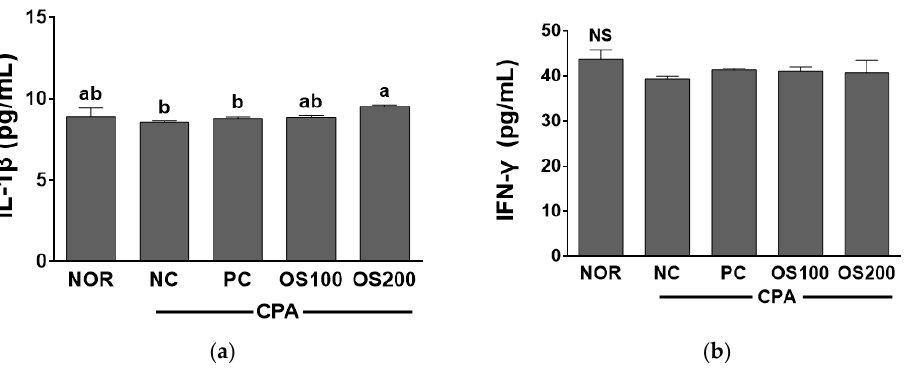
Figure 8. Effects of A. cepa skin (OS) extract on the serum ( a ) IL-1 β and ( b ) IFN- γ levels in C57BL/6 mice immunosuppressed by cyclophosphamide (CPA). NOR, normal control group; NC, negative control group; PC, positive control group; OS100, OS extract 100 mg/kg BW; OS200, OS extract 200 mg/kg BW. Data was expressed as the mean ± SEM. a,b Different letters are significantly different at p < 0.05. NS Not significantly different.